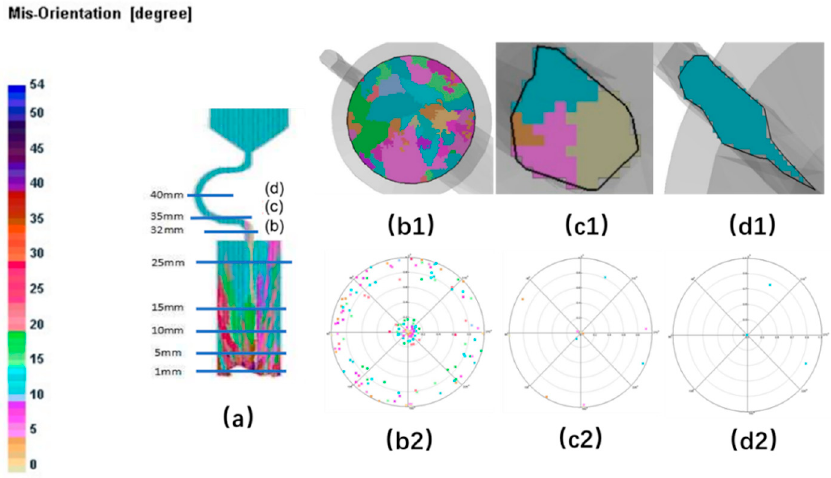
Figure 8 . Simulation structure of C 1 (2.4 mm) ( a ); EBSD (Electron Back Scattered Diffraction) maps of